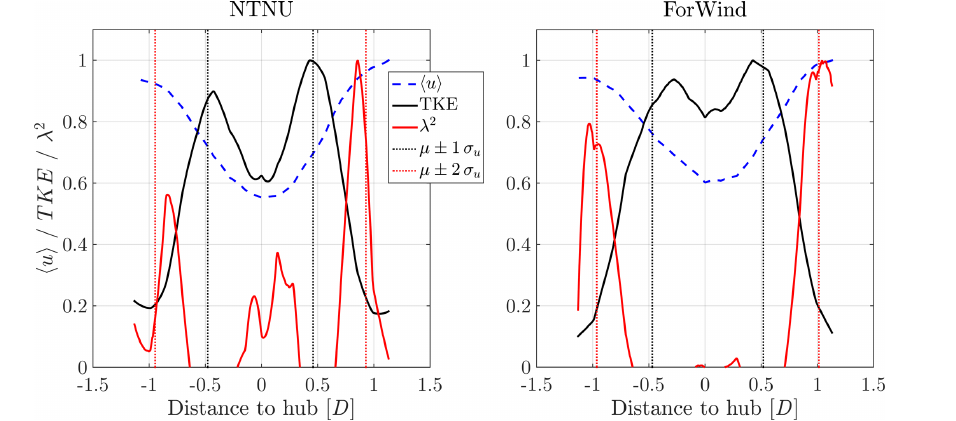
Figure 9. Diagonal cuts on the line y = z through the contour plots for γ = 0 ◦ . Values are normalized to their respective maximum. The vertical dotted lines mark µ ± 1 σ u (black) and µ ± 2 σ u (red) of a Gaussian fit through the velocity deficit shown in blue.